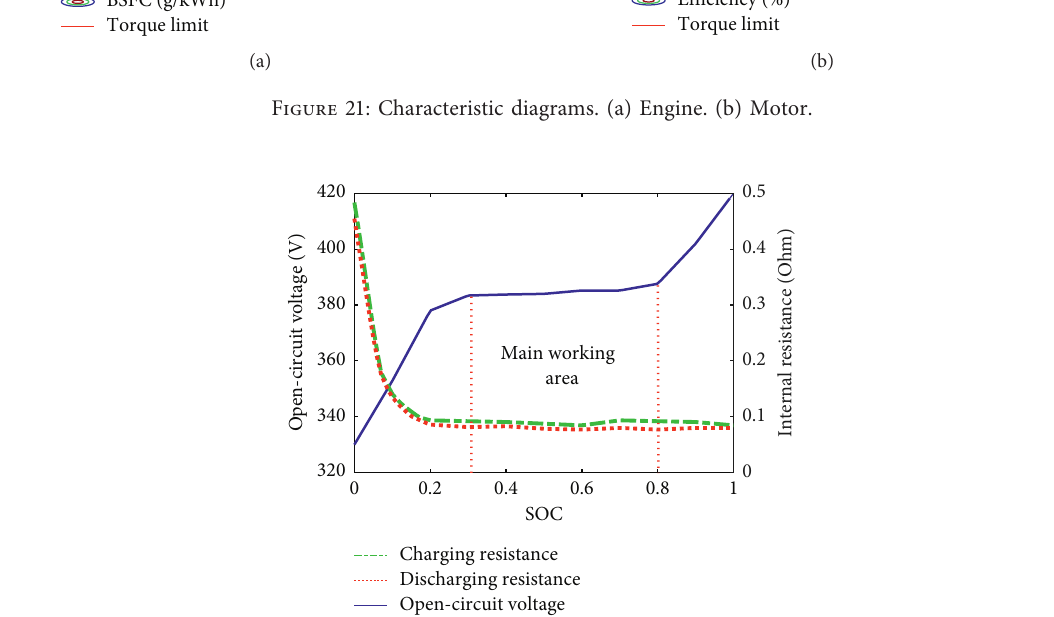
Figure 22: Characteristic curves of the battery